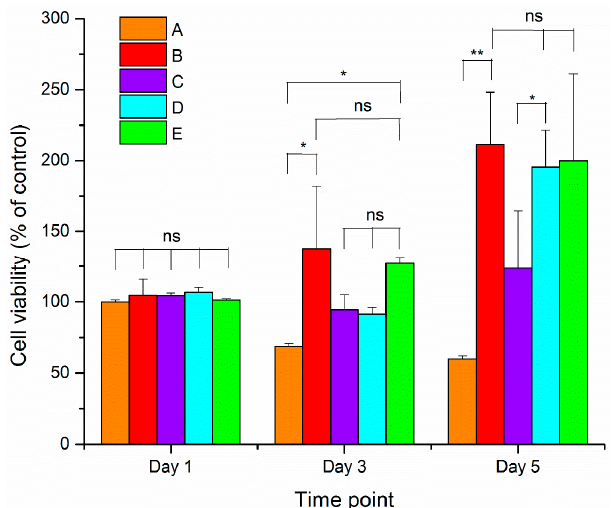
Figure 6. Cell viability results of 3T3 cells grown on Mg-ferrite based PCL/Aloe vera fibers. A and B represent the 100:0 and 70:30 PCL/Aloe vera fibers with 0% Mg-ferrite nanoparticles, respectively. C, D and E represent 70:30 PCL/Aloe vera fibers containing 5%, 15% and 25% Mg-ferrite nanoparticles, respectively. Cell viability data were analyzed for statistical significance using paired t -test ( n = 3). A statistical significant of p < 0.05 is indicated by * and p < 0.005 by **. Statistical insignificant of p > 0.05 is indicated by ns.